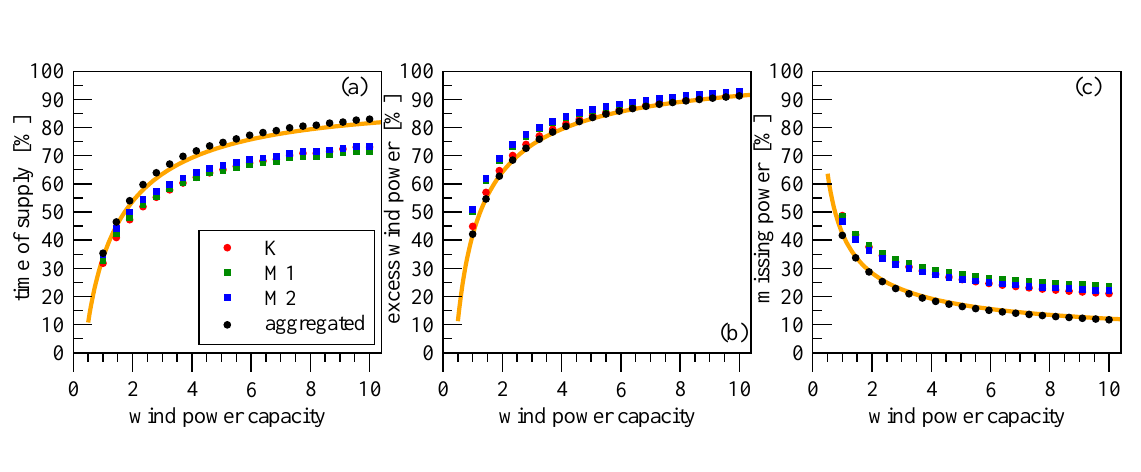
Figure 8. The same as Figure 7, by assuming a constant relative power consumption of